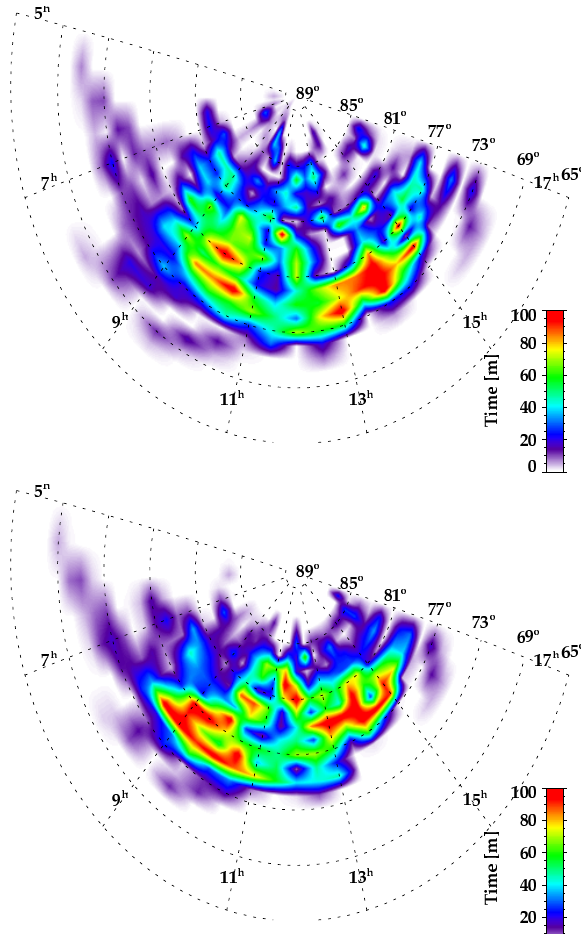
Fig. 2. The number of minutes of cusp-like plasma observations in 0.5h × 1 ◦ (MLT × MLAT) bins plotted in original (top) and corrected (bottom)